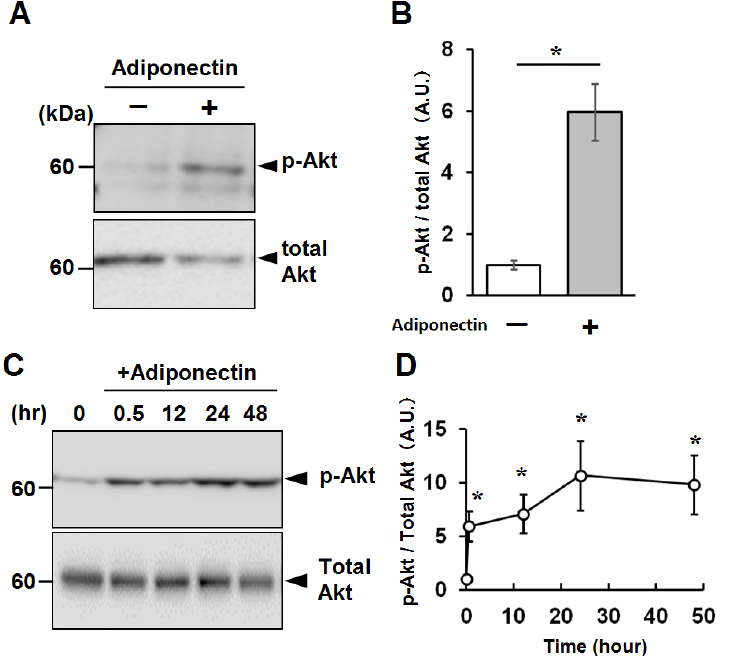
Figure 5. Recombinant adiponectin promotes Akt phosphorylation in C2C12 myotubes. ( A ) Pre- starved C2C12 myotubes were incubated in the absence ( − ) or presence (+) of 1 µg/mL recombinant adiponectin for 5 min, and cellular proteins were analyzed by western blotting using anti-phospho- Akt (p-Akt) and pan-Akt (Total) antibodies. A representative result from one of three independent experiments is shown. ( B ) Densitometric analysis of the western blot in ( A ). The mean ratio of phospho-Akt/total Akt ± SD is indicated. The Student’s t -test was used for statistical analysis. *: p < 0.05. ( C ) Time course of the Akt stimulation of C2C12 myotubes. C2C12 myotubes cultured in